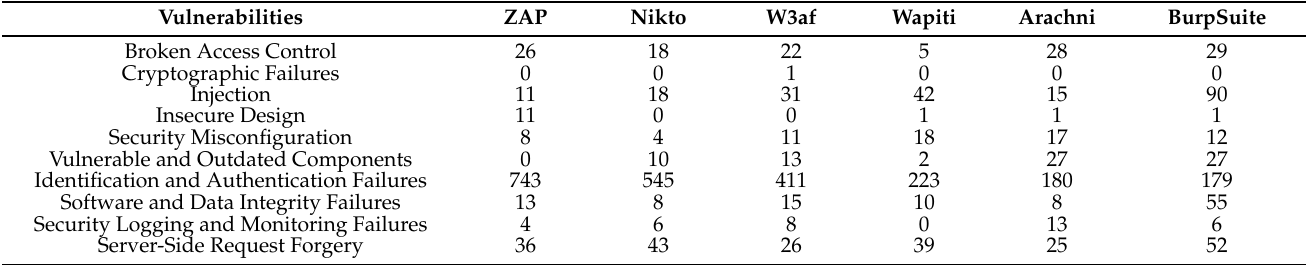
Table 4. Total number of vulnerabilities classified and detected by open-source scanners. Vulnerabilities ZAP Nikto Arachni Broken Access Control